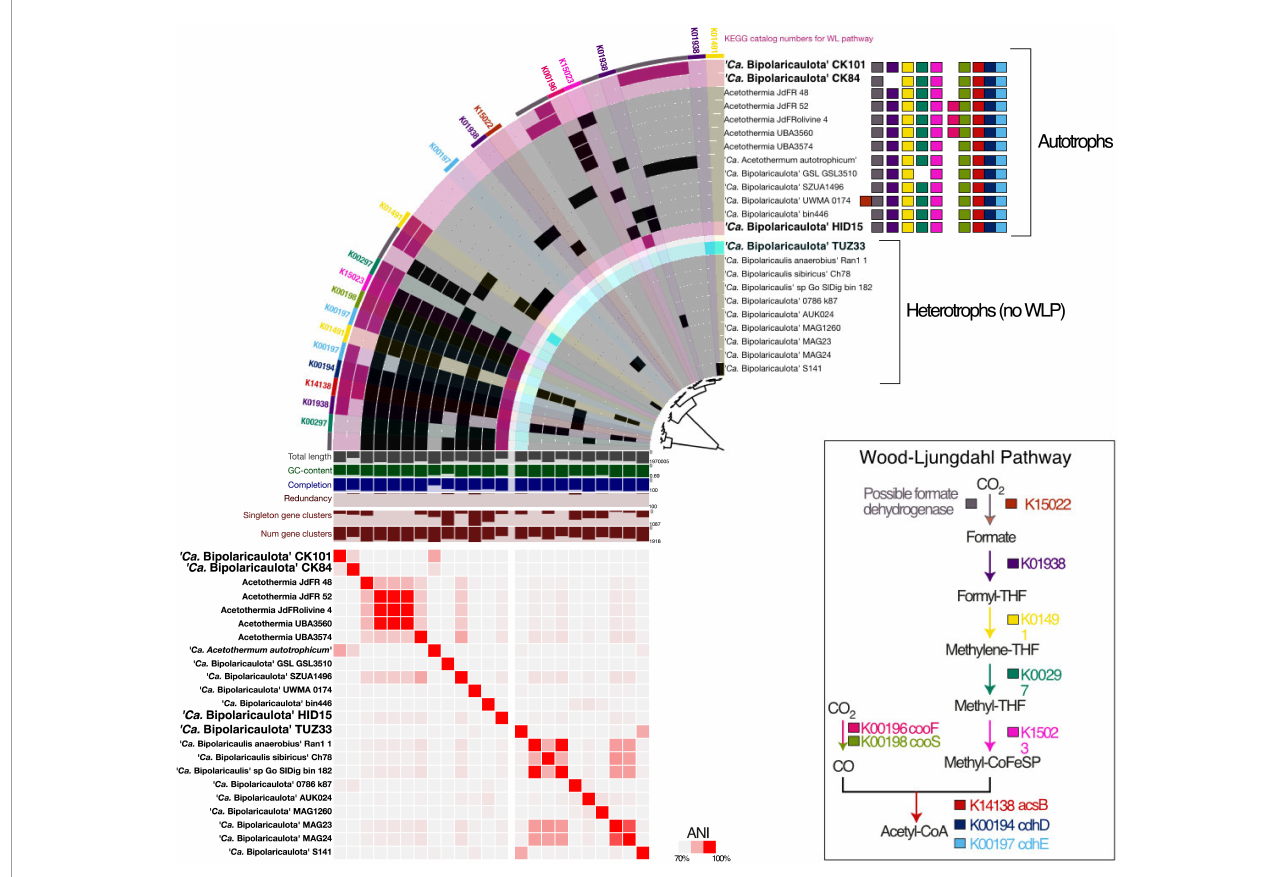
FIGURE5 Comparative genomic analysis of gene clusters encoding Wood-Ljungdahl pathway (WLP) (top row) , and those lacking the WLP (bottom row) . The metagenome-assembled genomes (MAGs) recovered in this study are shown with bold letters and bigger font size; the MAGs taken from the public databases are displayed in black with relatively smaller font size. The heatmap shows average nucleotide identity between MAGs across the entire core genome. Values were calculated in the anvio v7 using pyANI (Pritchard et al., 2016). The colored squares represent the enzymes catalyzing the